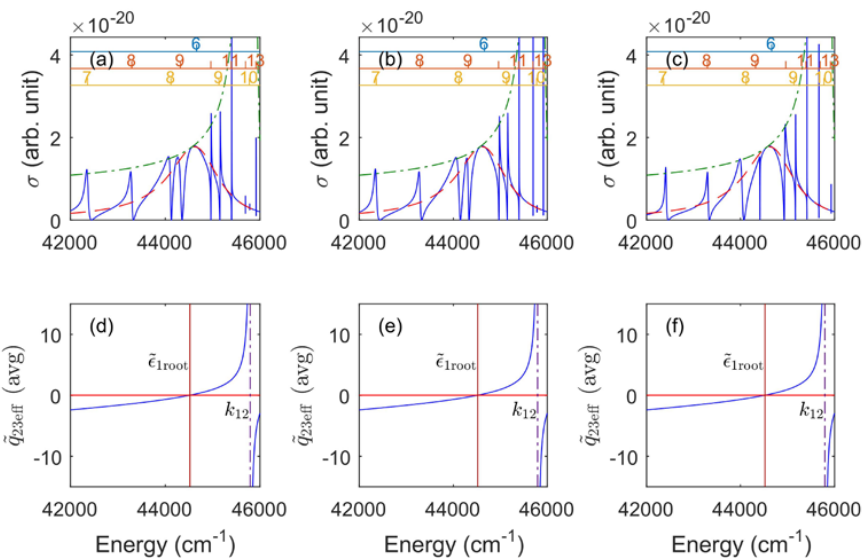
Figure 7. Effect of the strength of (cid:101) K 23 between series 2 and 3 on the autoionization cross section σ . ( a ) (cid:101) K 23 = − 0.15, ( b ) (cid:101) K 23 = 0.05, ( c ) (cid:101) K 23 = 0.6 (from [37]).